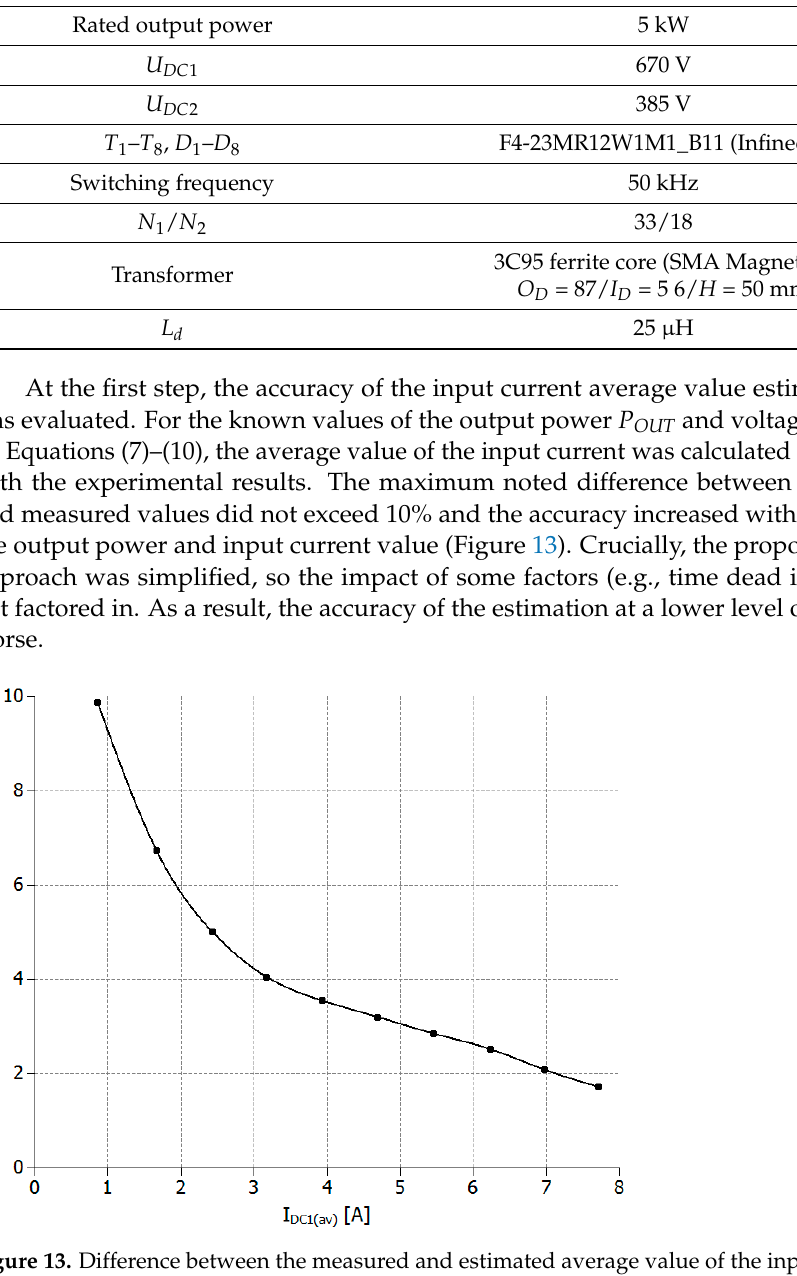
Figure 13. Difference between the measured and estimated average value of the input current i DC 1 .